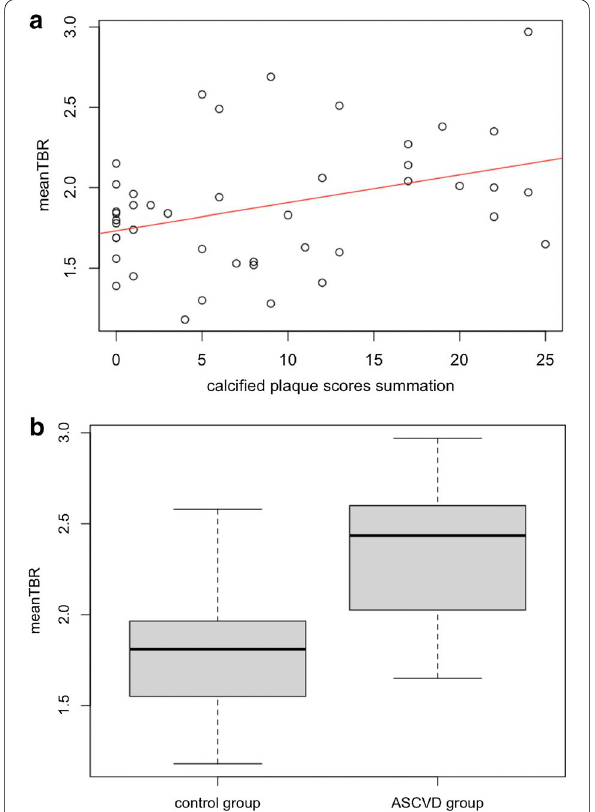
Fig. 3 A Scatterplot showing correlation of mean TBR of 68 Ga-NODAGA-RGD uptake and calcified plaque scores summation of eight arterial segments on per-patient basis. B Box plot showing mean TBR for all patients, separated into those with clinically